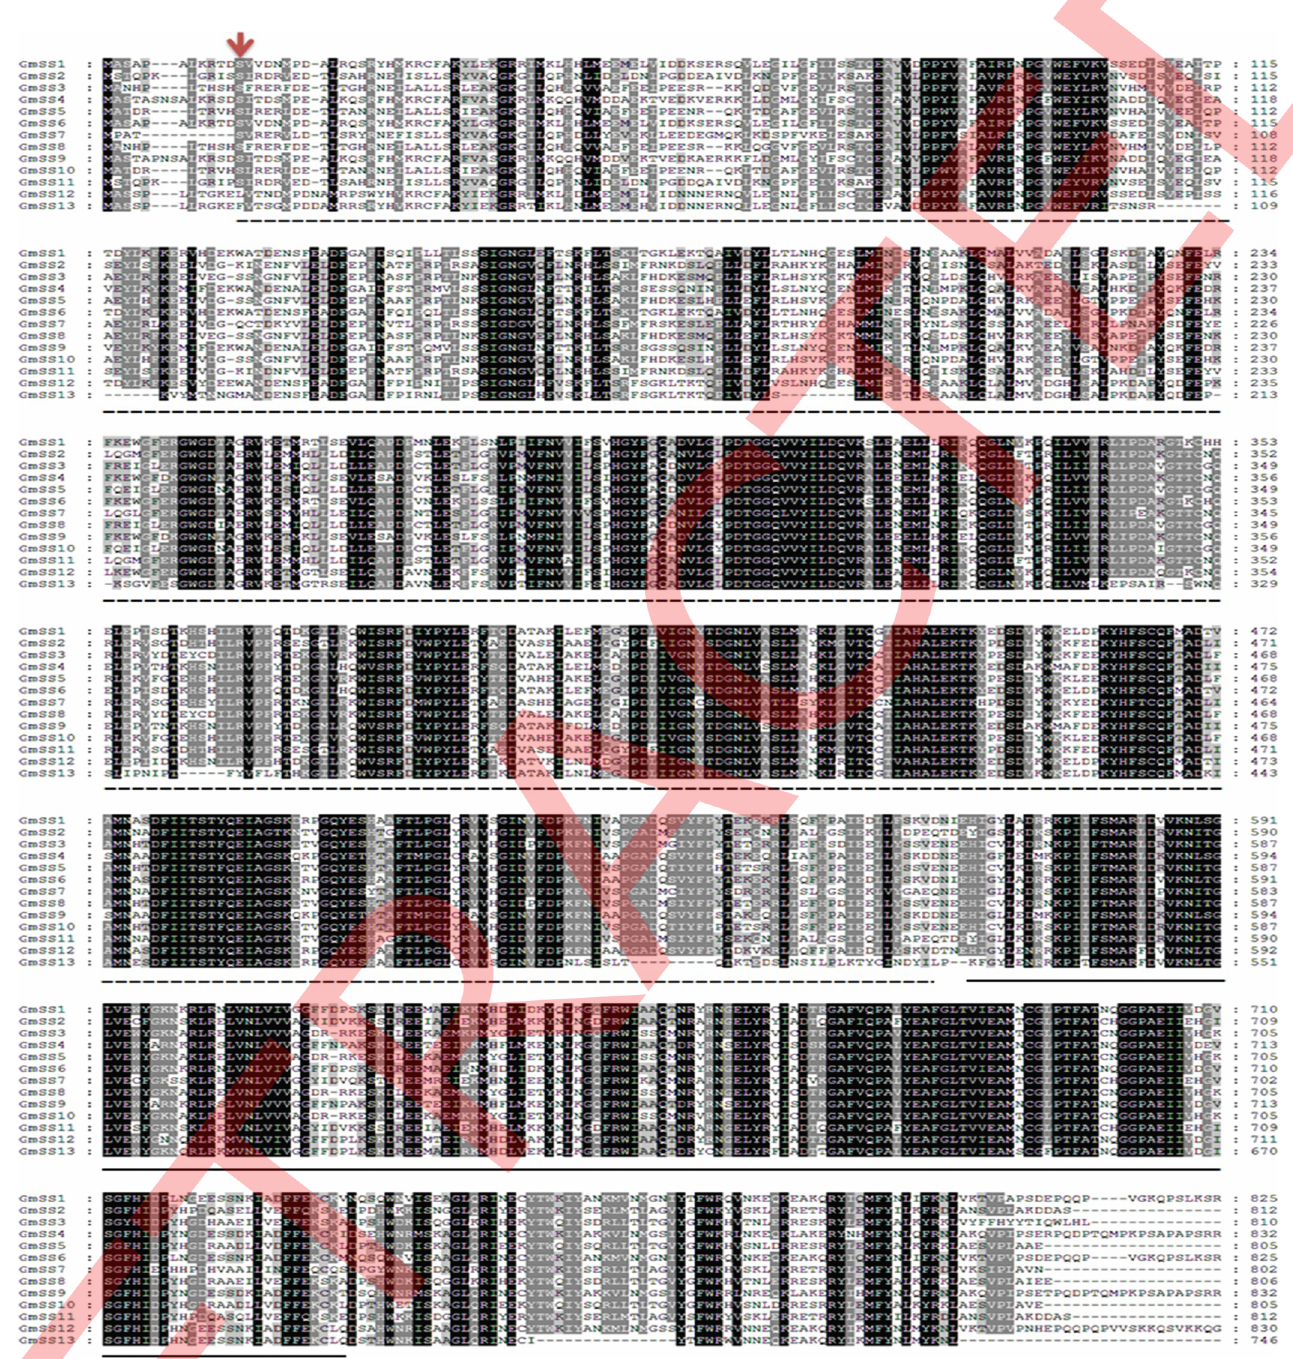
Fig 1. Predicted amino acid sequences of thirteen GmSS genes. Amino acid sequence alignment of 13 GmSS proteins was done with MEGA7. MEGA7 alignment was used in GeneDoc program to shade the identical and similar amino acids in alignment. The conserved serine residue for phosphorylation by Ser/Thr protein kinase is showed by an arrow-head. The characteristic sucrose synthase domain (broken underline) and a glycosyl transferases domain (single underline) were identified by the Interproscan algorithm (http://www.ebi.ac.uk/Tools/pfa/iprscan/). Dark shad represents identical amino acids and grey shade indicates similar amino